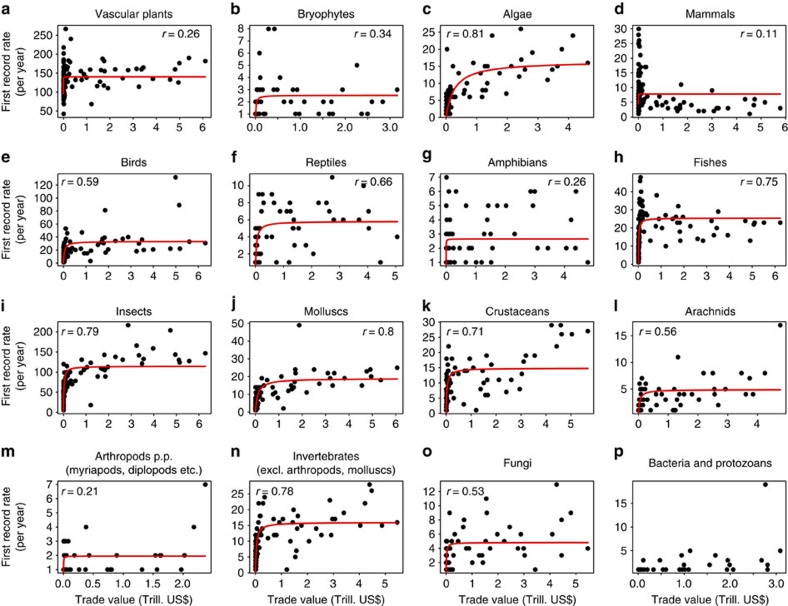
Relationships between the values of annually imported commodities and first record rates.Relationships between the values of annually imported commodities and first record rates of the same regions for all taxonomic groups separately (a–p). Each dot represents a single year during 1870–2000, depending on data availability. Following previous studies2021, a Michaelis–Menten curve (lines) was fitted to test for an improved fit using a nonlinear relationship with an attenuation of first record rates at large import values. The goodness-of-fit between observed data and the fitted curve is indicated by the Pearson's correlation coefficient given in the upper left corner of sub-panels, except for bacteria and protozoans, where the fitting function did not converge.